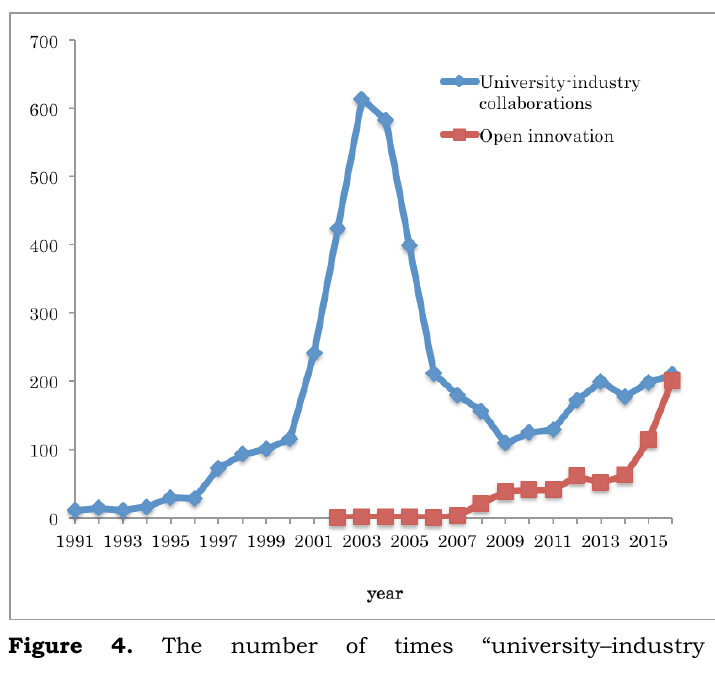
Figure 4. The number of